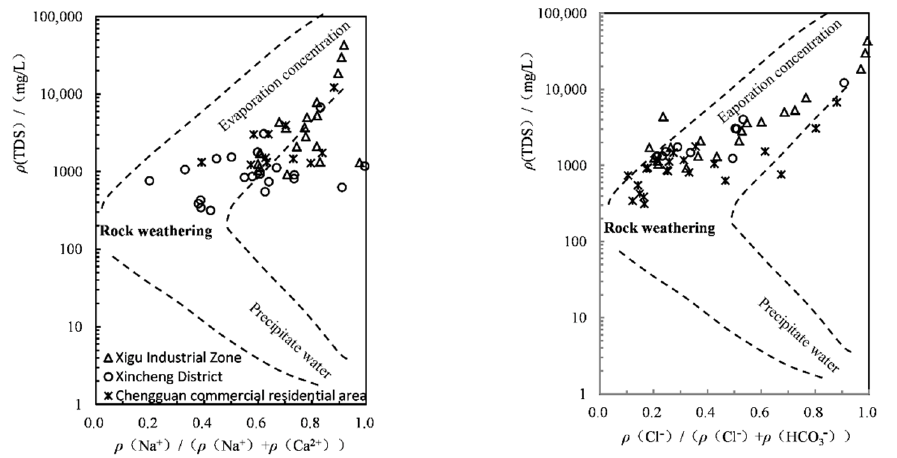
Figure 10. Gibbs graphs of the water chemical compositions.